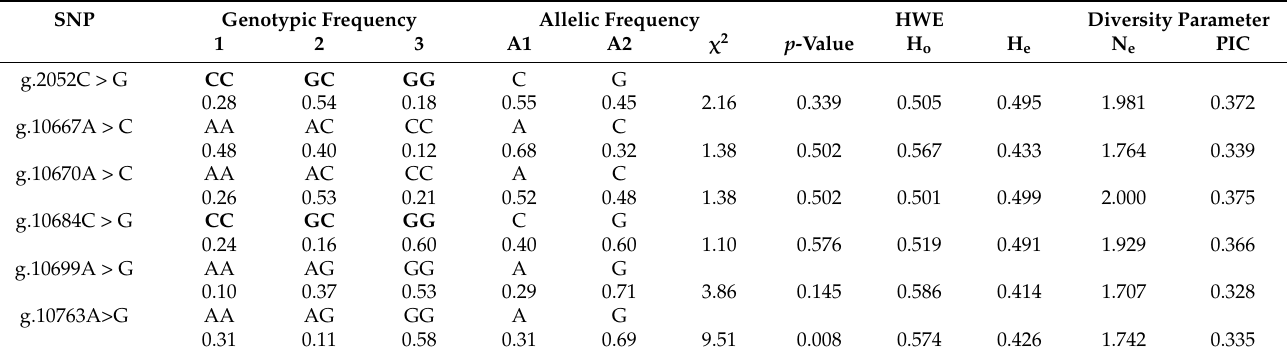
Table 3. Genotyping and population genetic analysis in GHRHR .